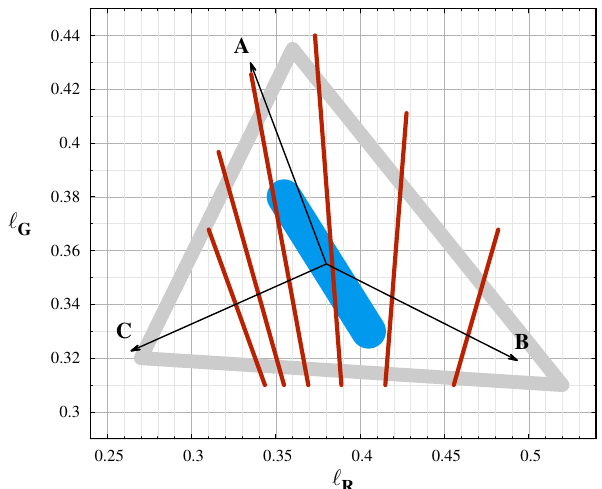
Figure 1. The possible colour range of natural night sky colours. The most probable colours are inside the grey triangle. The cyan band indicates the standard sky with no extreme airglow and with no light pollution. The arrows indicated the possible shifts by different sources: A: Green oxygen airglow, B: Sodium airglow, C: Twilight. The red lines indicate the approximate equi-CCT curves with CCT = 5500, 5000, 4500, 4000, 3500 and 3000K (from left to right